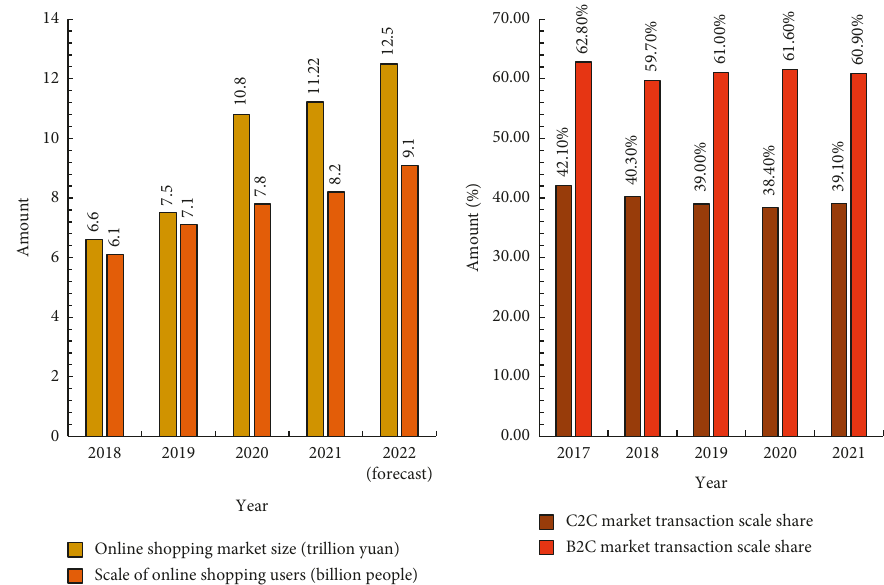
Figure 10: Market size of Internet shopper and comparison of B2C and C2C market shares in